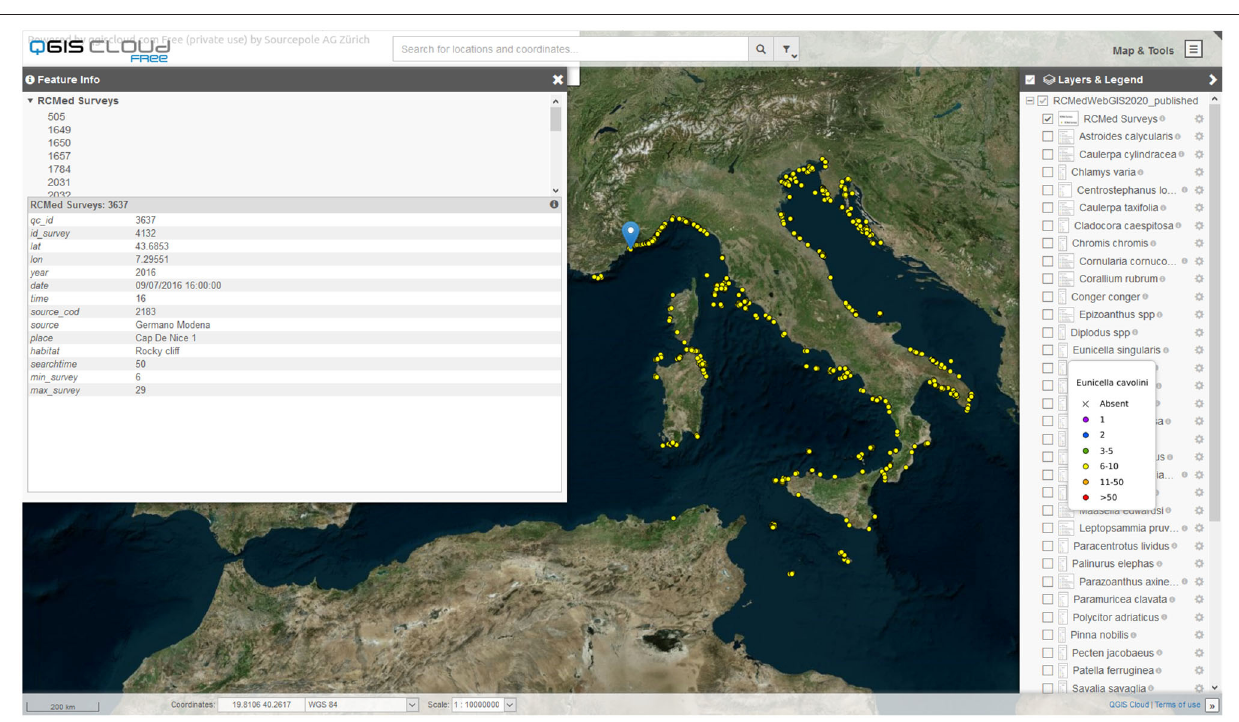
FIGURE 5 | Web GIS screenshot shows some data interrogation options: on the left, the data of a single survey and on the right, the list of species layers that can be activated with the relative symbol legends, which display the abundance classes (see Table 2